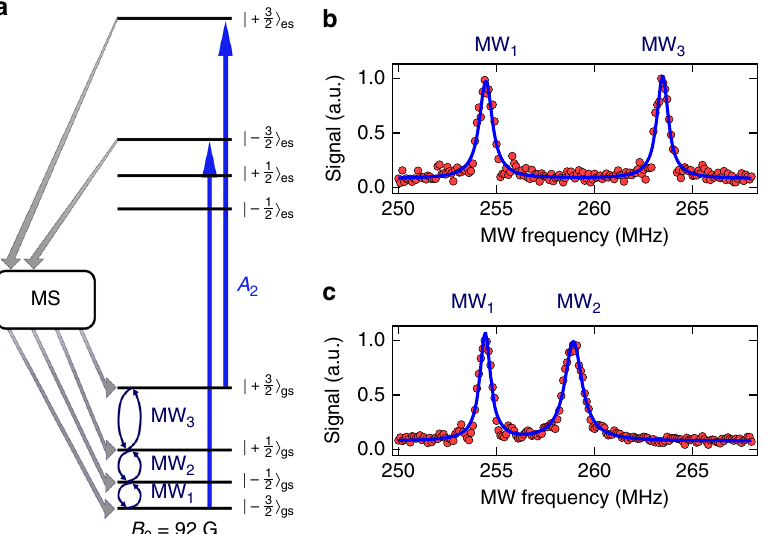
Fig. 2 Optically detected magnetic resonance. a Level scheme indicating the used optical transition ( A 2 ) and microwave fi elds MW 1 , MW 2 and MW 3 . Spin fl ips occur via nonradiative channels involving metastable states (MS). b ODMR signal of the ground state after initialising the system into ± 1 c ODMR signal after initialisation into (cid:1) 1